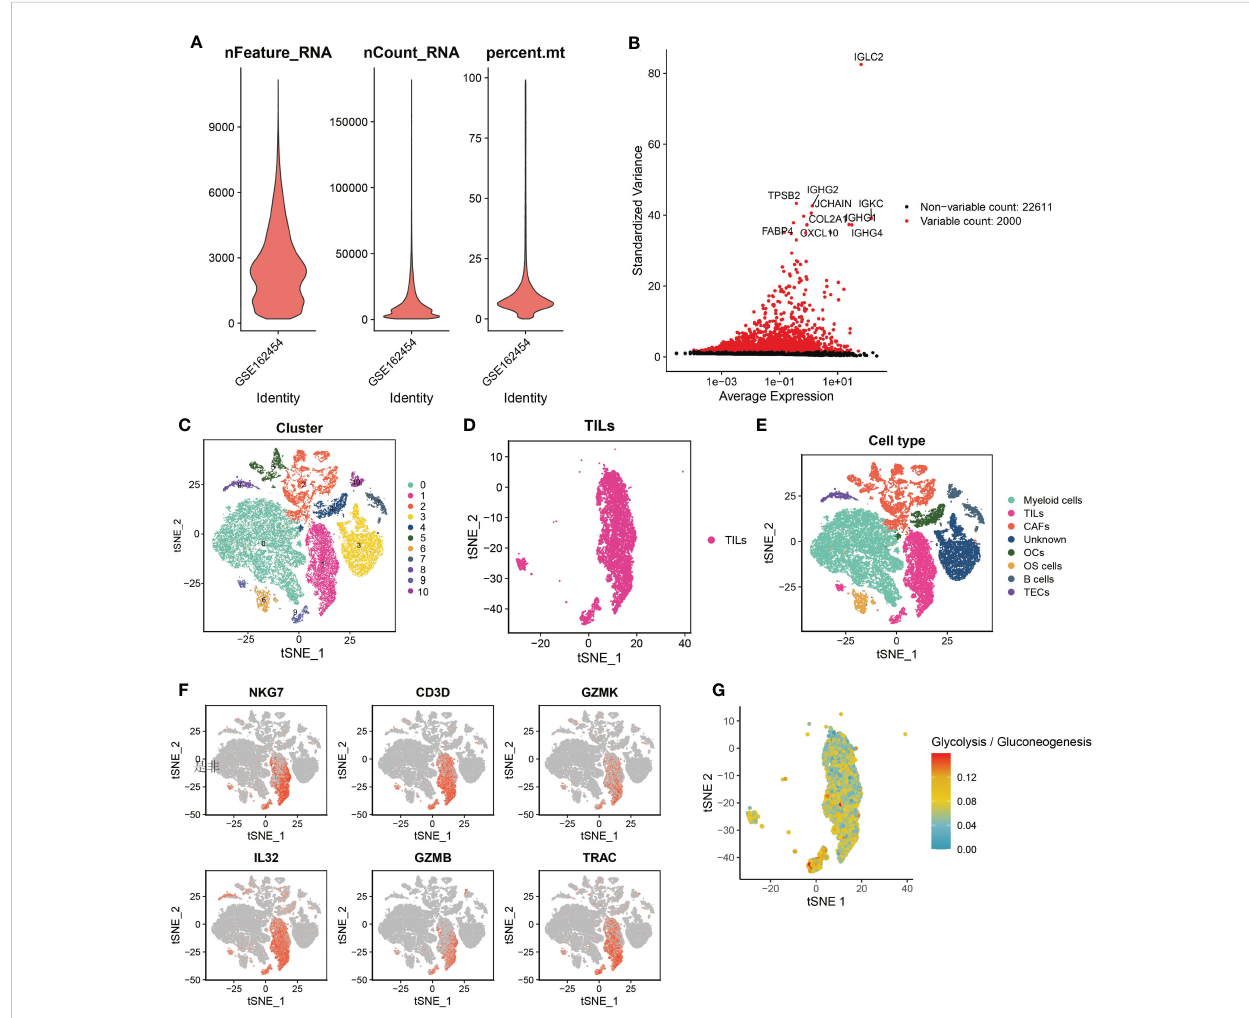
FIGURE 1 Quality control of cells and the single-cell RNA sequencing to identify TILs markers. (A) Violin plot of 3 cell quality control standards. (B) The top 2,000 high variance genes. (C) t-SNE plots sorted by cell clusters. (D) t-SNE plots colored by the same cell type. (E) Different cell clusters identi fi ed by marker genes. (F) TILs identi fi ed by 6 marker genes. (G) single cell metabolic features of TILs are related to glycolysis or